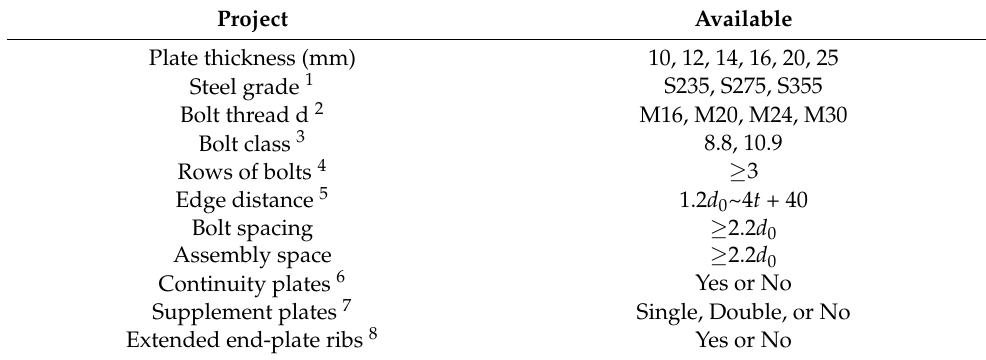
Table 2. Parameters for a connection.